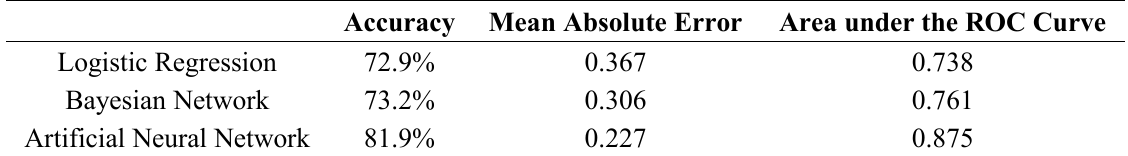
Table 1. Performance of customized mortality predictions models for ICU patients who developed acute kidney injury (AKI).